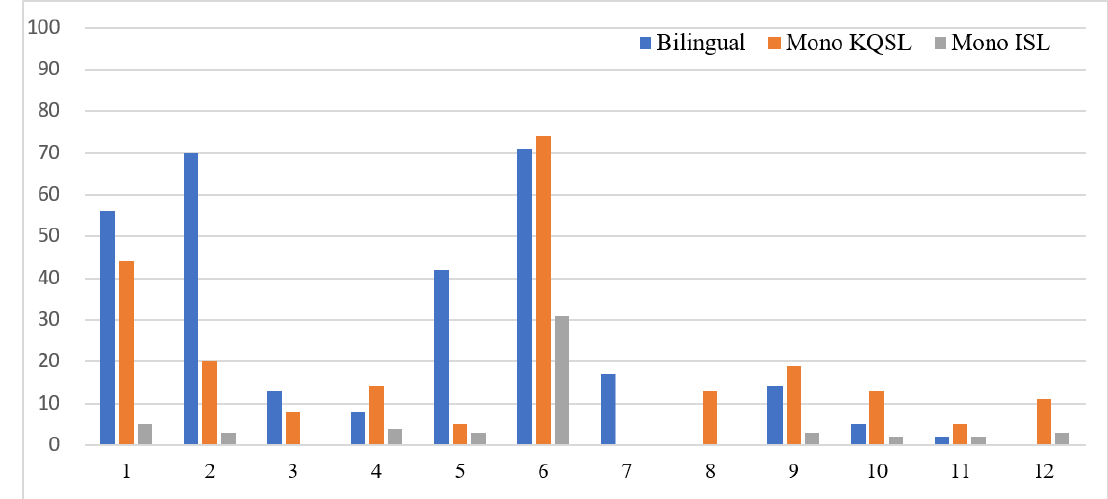
Figure 3. Percentage of KQSL lexical sign use by individual, presented across conditions. Table 6. Significant Rbrul results (by